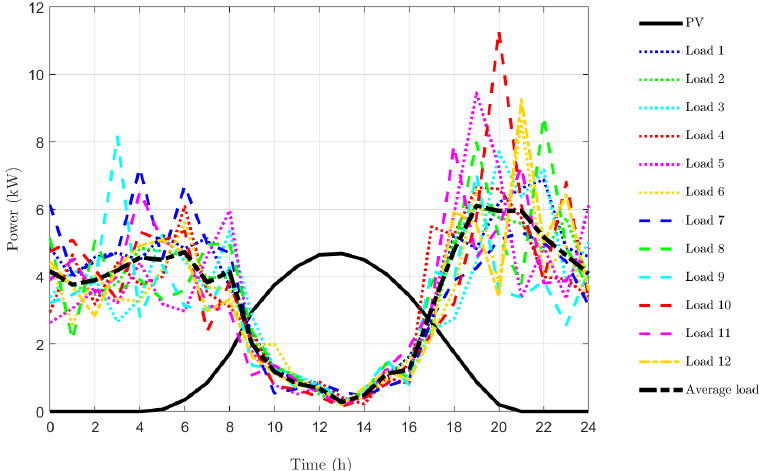
Figure 6. Solar PV power and house load profile (House 1 to House 12) for a day.